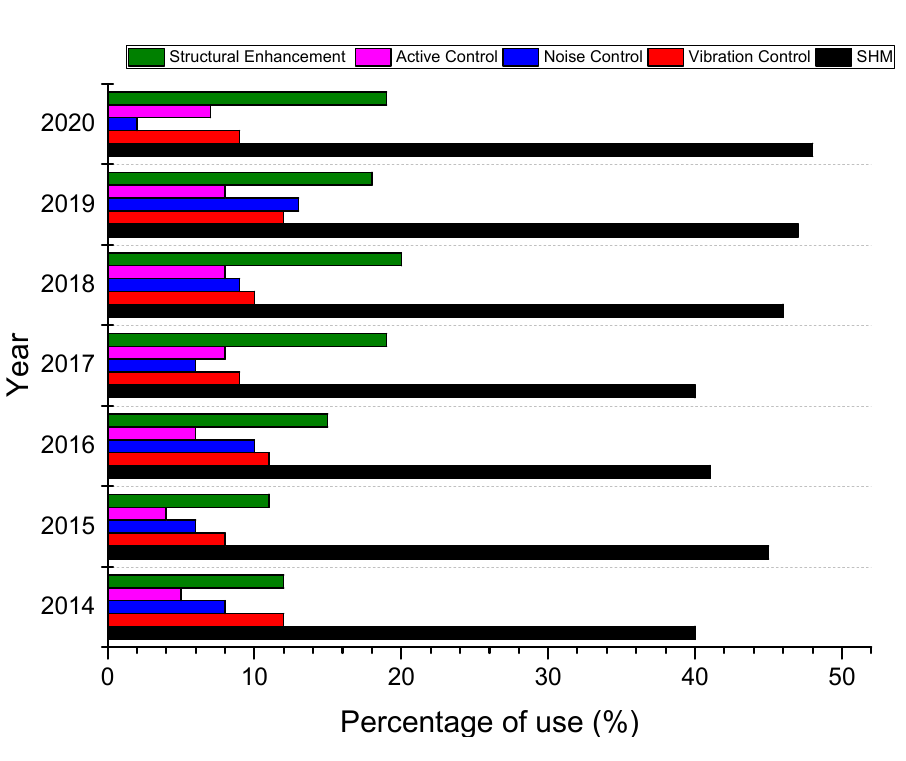
Figure 10. Trends in piezoelectric research. Table 1. Summary of previous work based on the structural control/repair.